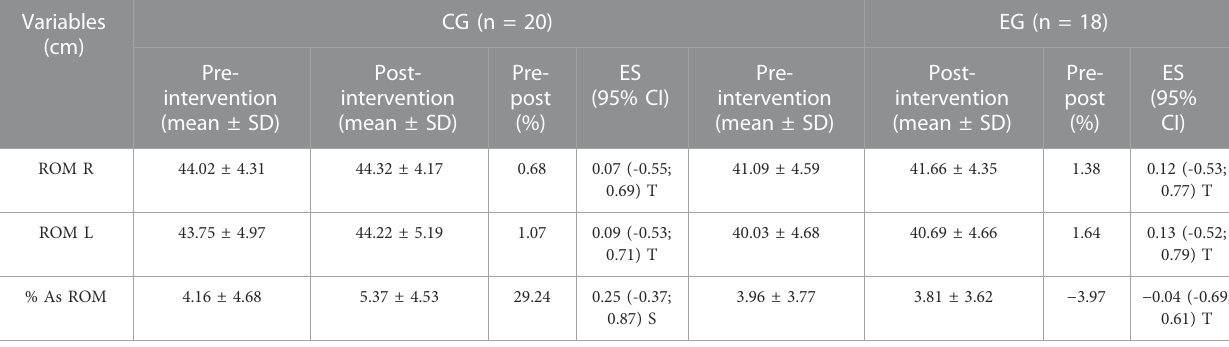
TABLE 1 Results of the range of motion variables in the control and experimental group. Variables